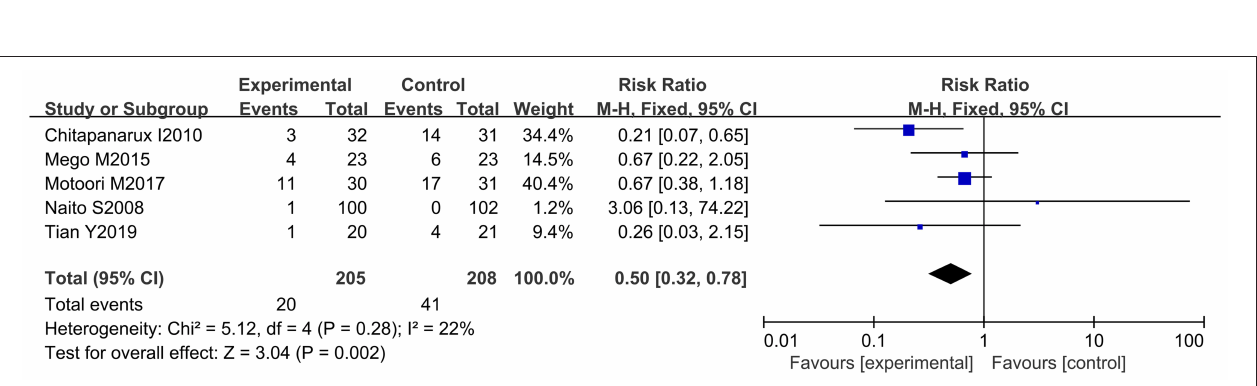
Frontiers in Nutrition |